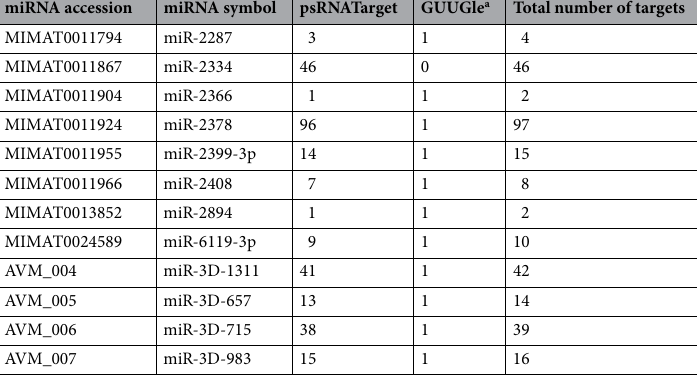
Table 4. Number of targets predicted by psRNATarget and GUUGle in FMDV for Bos taurus miRNAs. a GUUGle was used as a confirmatory tool to check whether at least one target is predicted by this tool for the miRNA whose targets have been predicted by